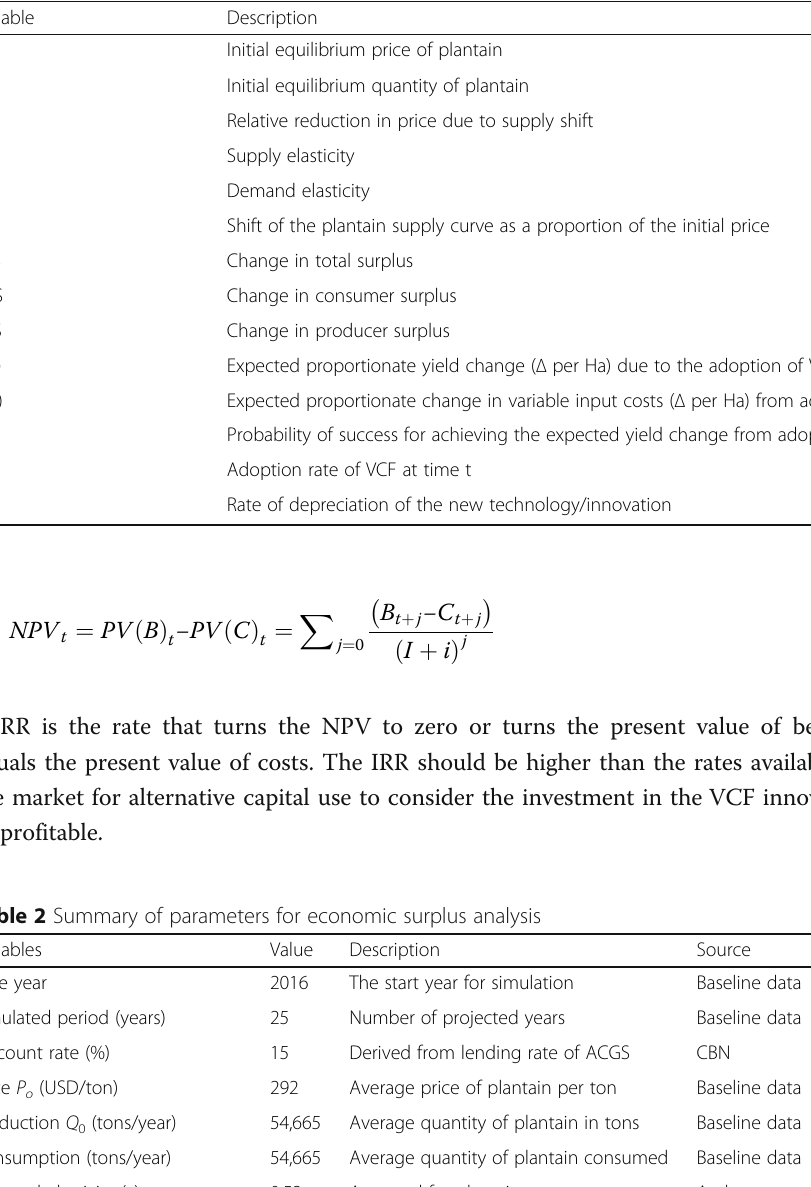
Table 1 Notations and description